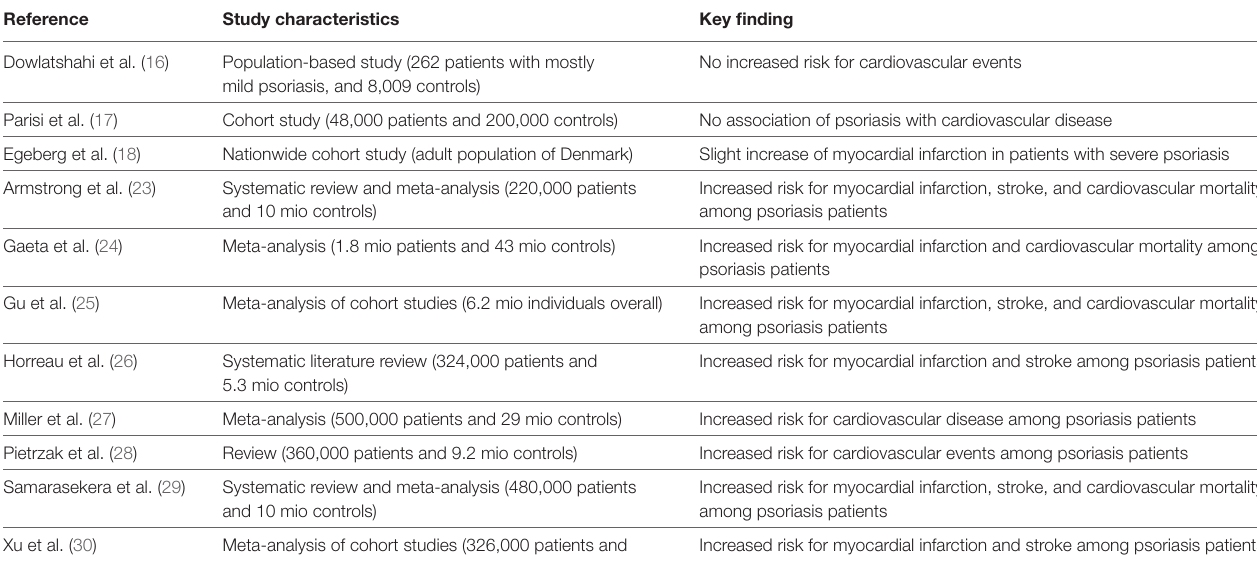
Table 1 | Summary of studies analyzing the association between psoriasis and major adverse cardiovascular